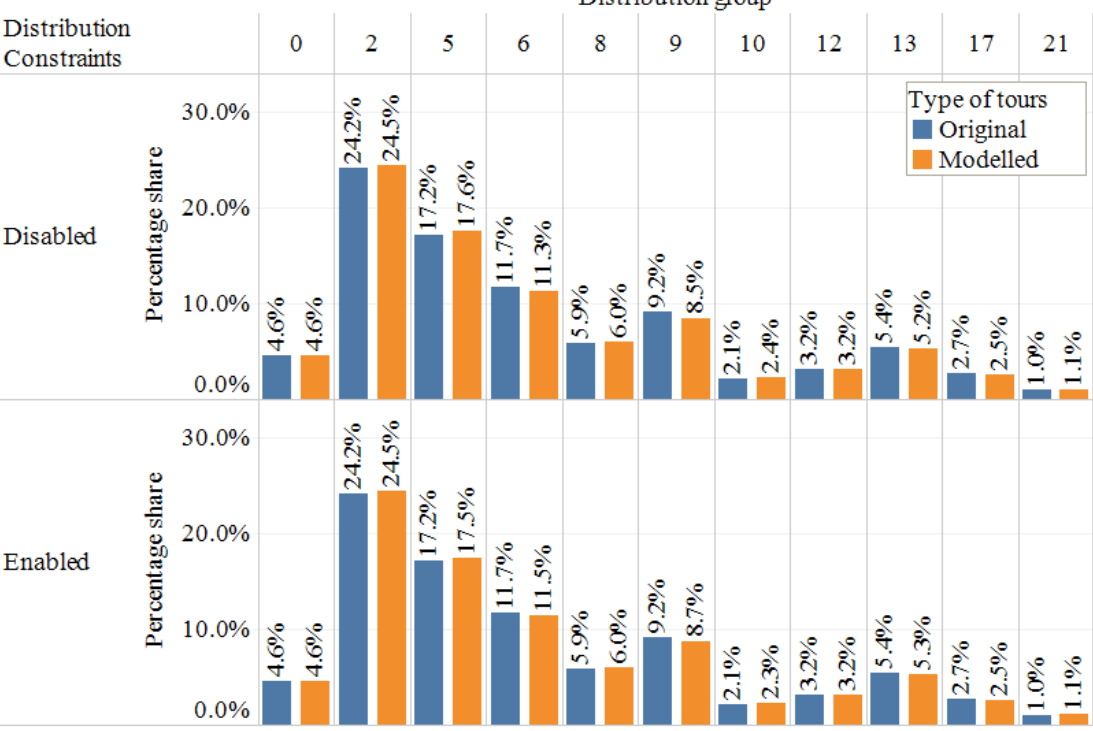
Figure 6. Comparison of distributions between original and modelled tours with a share greater than 1%. (Scenarios 1-2)